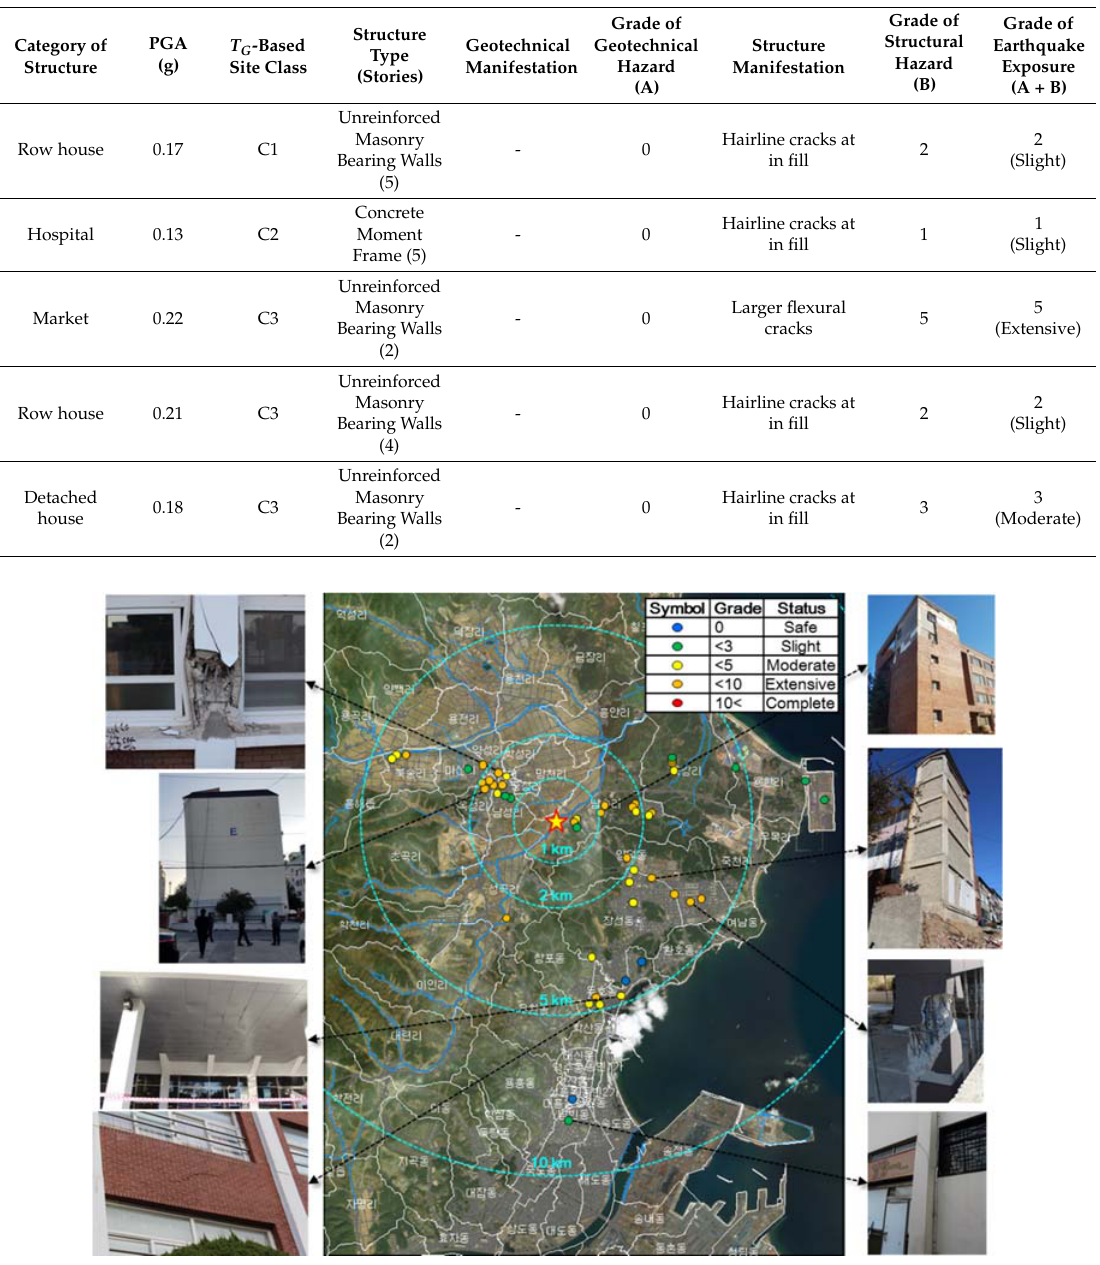
Table 4. Example of the post-earthquake impact of the 11.15 Pohang earthquake.